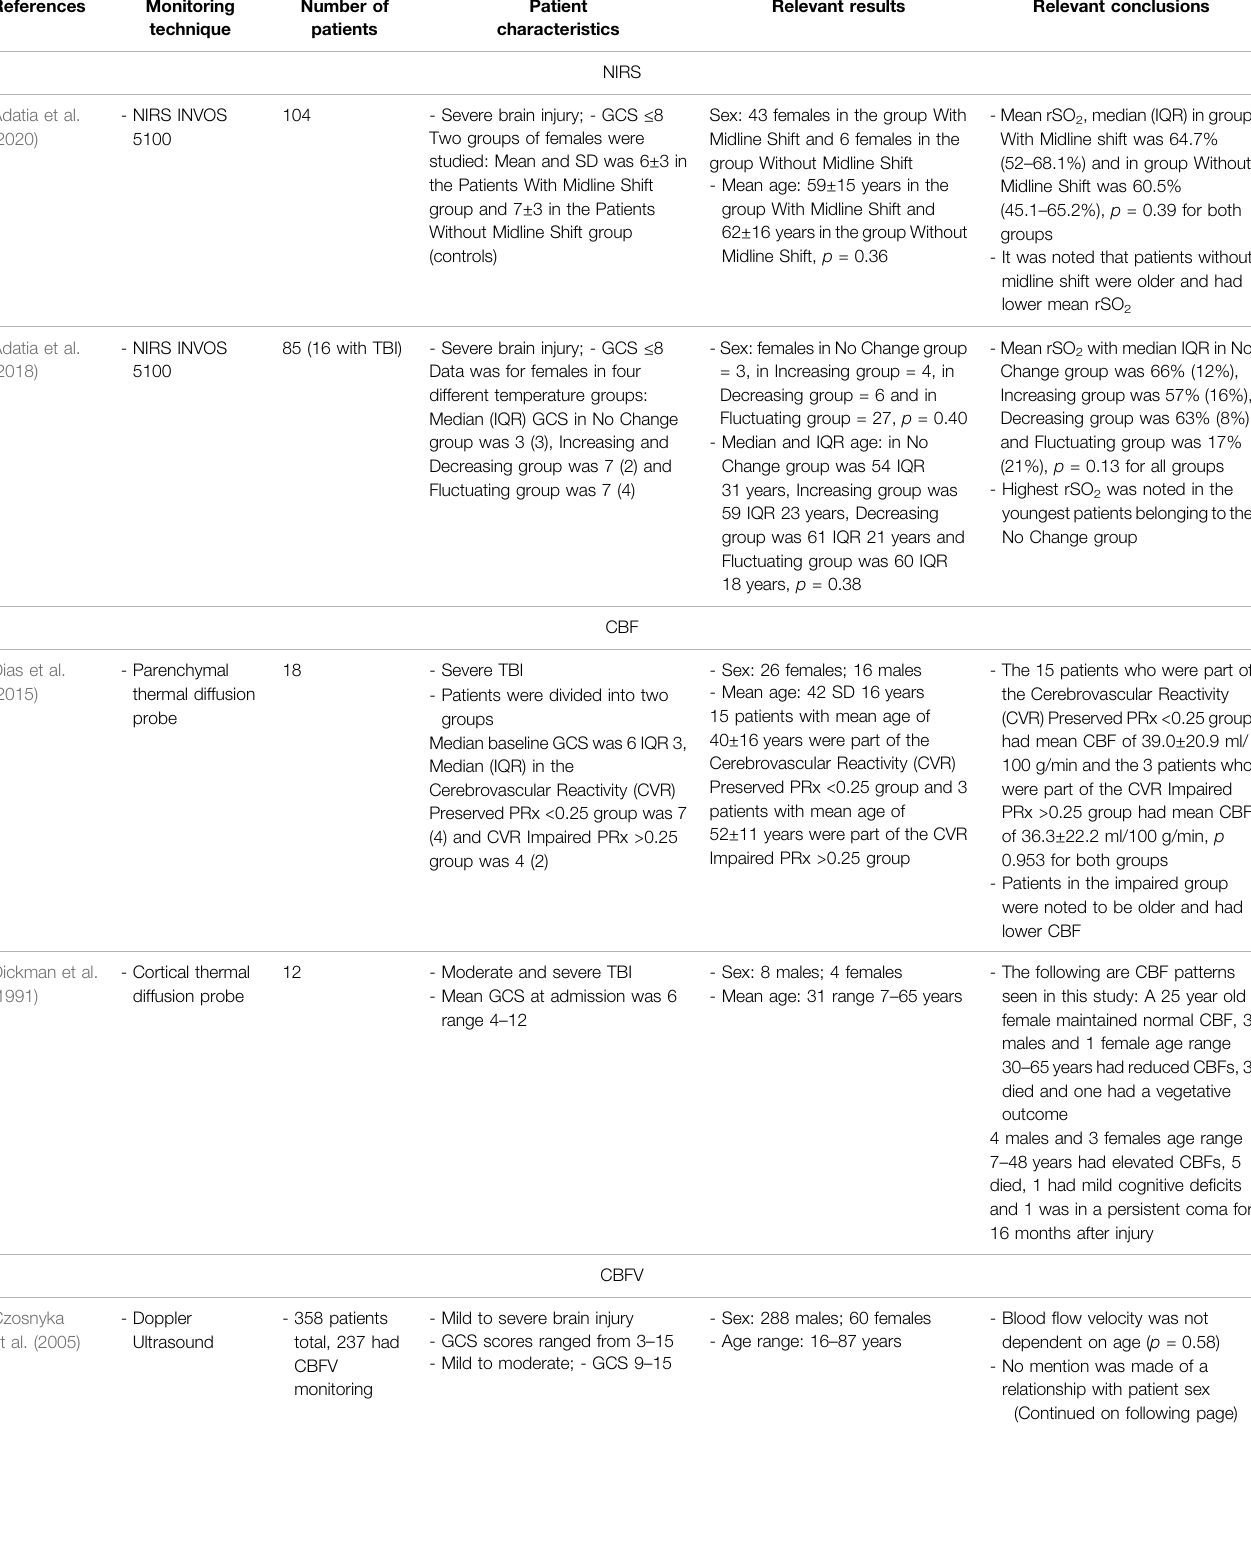
TABLE 2 | Main representative studies evaluating link between NIRS, TDF-based CBF and CBFV with age/biological